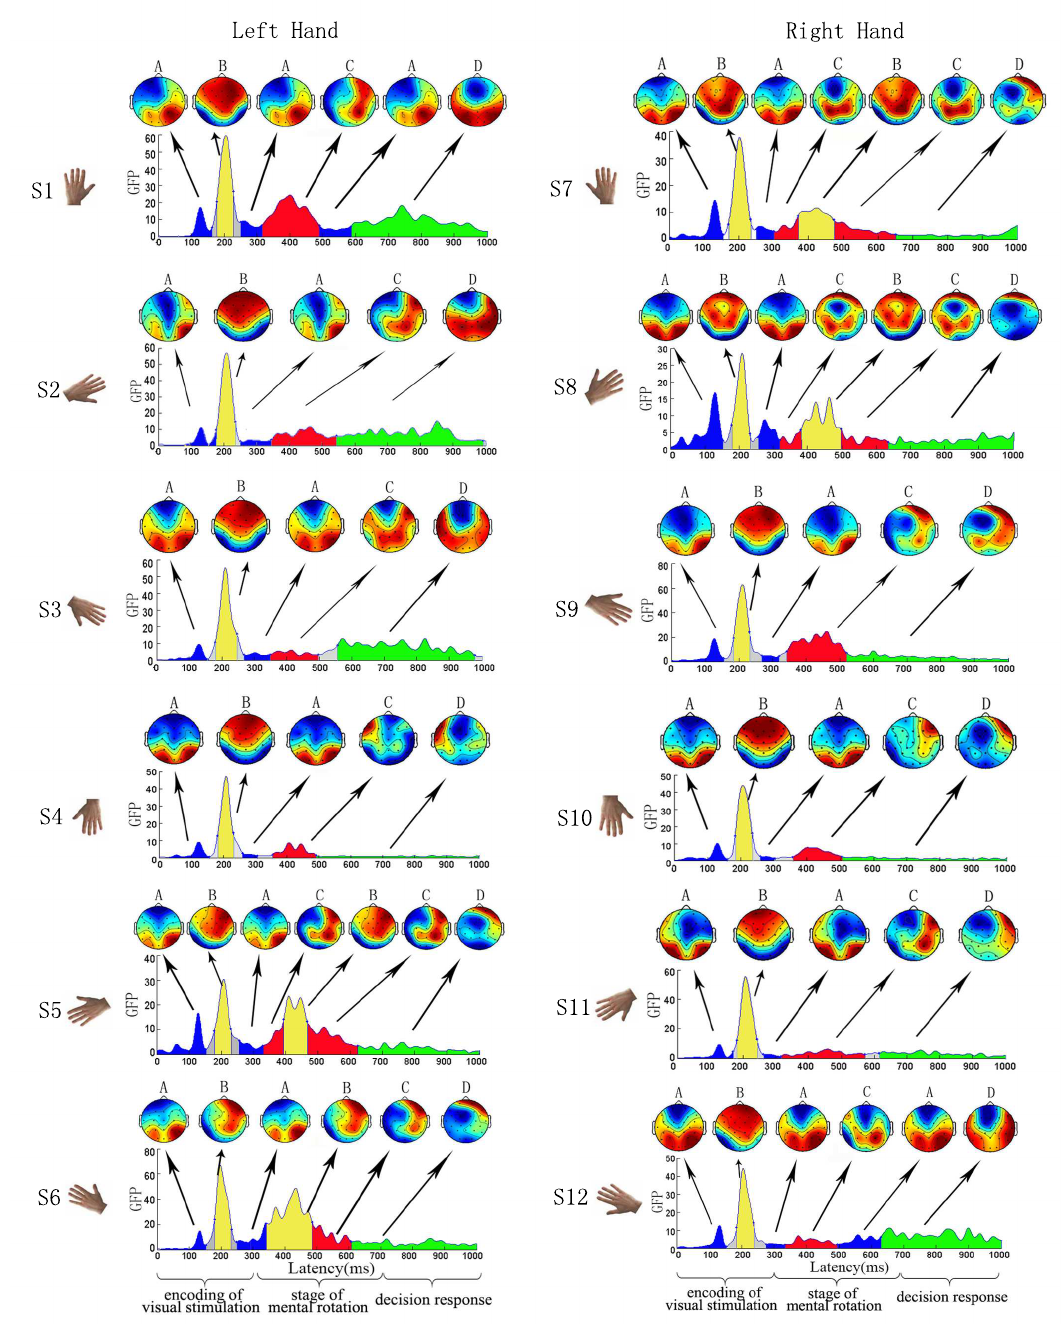
Figure 2. Feature of microstate modes (i.e., A, B, C, D) for 12 visual stimuli. Global field power (GFP) and functional microstates of mental rotation were analyzed by 12 visual stimuli. Four functional microstate modes (marked in blue, yellow, red and green, respectively) were found in the stimuli S1 to S12. The topographical maps were shown to be located at the time intervals corresponding to the microstates. During the encoding of visual stimulation, the microstates sequence had a specified sequential mode A → B → A in all different visual